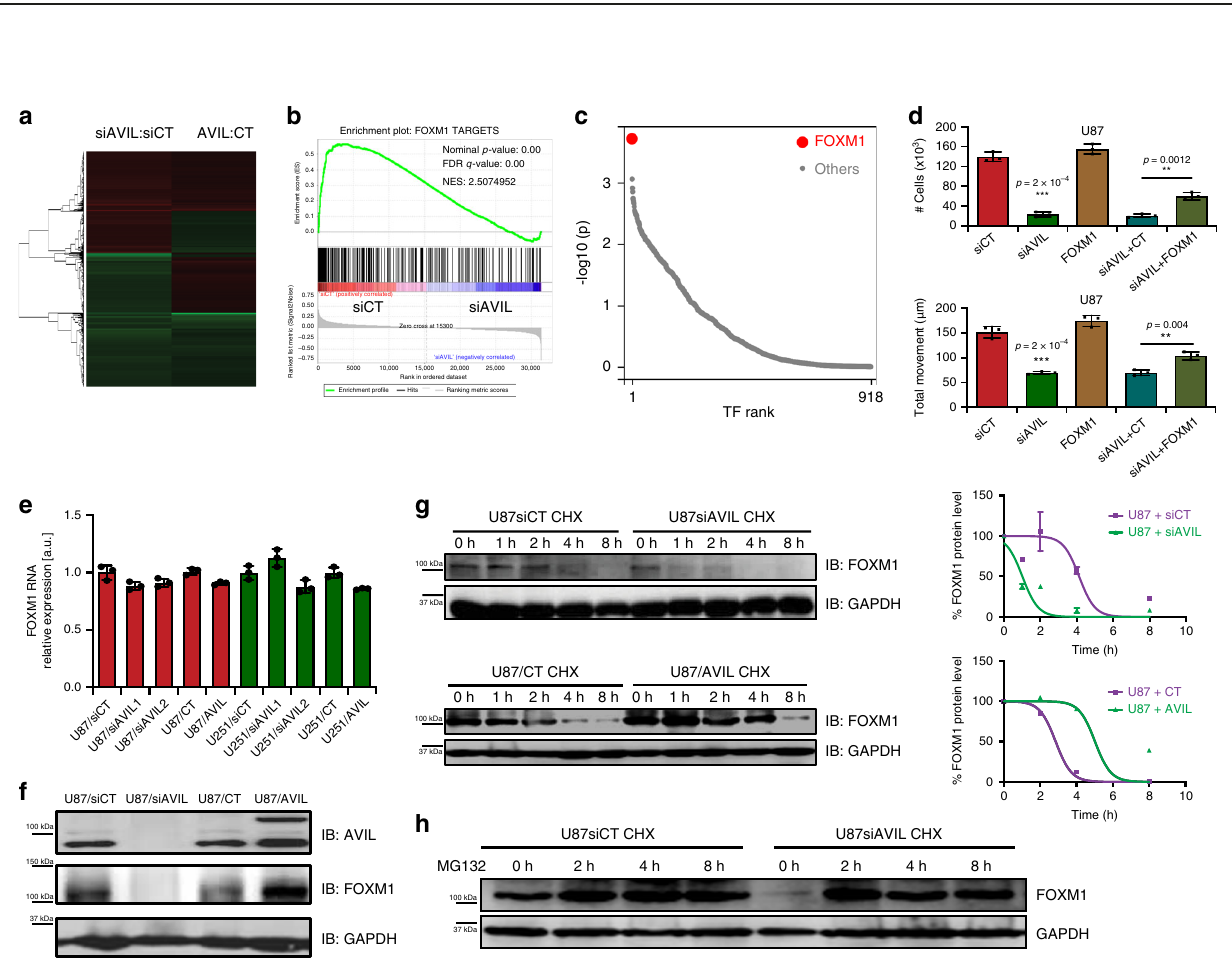
Fig. 6 AVIL binds to F-actin, and the interaction is crucial for its tumorigenic activity. a AVIL colocalize with F-actin. U87 cells stably expressing GFP- AVIL (green) were stained for F-actin (Phalloidin, red) showing co-localization of AVIL and F-actin. b Fluorescence colocalization between F-actin and AVIL. Scatterplot representing the intensity range of red and green pixels in the image as shown in a . c AVIL binds directly to F-actin. Silver-stained SDS- PAGE analysis of actin high-speed pelleting of F-actin in the presence or absence of AVIL. d Silencing AVIL resulted in reduced ability of A172 cells to spread. e Cell area was plotted for A172 cells transfected with siCT, or siAVIL1. Signi fi cant difference ( p = 0.0014) was observed by the two-sided Rank- Sum test (non-parametric test for non-normally distributed data). n > 50. f Amino acid sequence alignment of the C-terminal region of advillin and villin from eight species. Arrows indicate positions selected for mutagenesis; red arrows indicate positions of mutations used in experiments represented in g – j . g Mutations in the headpiece region of AVIL signi fi cantly reduce binding to β -actin in cells. Co-immunoprecipitation of β -actin by antibodies speci fi c to Myc-tag in cell lines expressing Myc-tagged AVIL WT or indicated mutants. Mutants indicated in red were subsequently utilized in experiments represented in h – j . IB – immunoblotting, IP – co-immunoprecipitation. h AVIL mutants are de fi cient in binding to F-actin. Silver-stained SDS-PAGE analysis of actin high-speed pelleting of F-actin in the presence or absence of AVIL in a buffer containing EGTA. i Mutations in AVIL headpiece region are not as effective as WT AVIL in stimulating cell proliferation (two-sided Student ’ s t- test). U87 cells were transfected with siAVIL and grown for 24 h followed by transfection with a plasmid overexpressing AVIL WT or indicated AVIL mutants. After 48 h, cells were counted. j Headpiece mutants failed to rescue de fi ciency in cell movement (two-sided Student ’ s t- test). Total movement of U87 cells expressing AVIL WT or indicated mutants in the wound-healing experiment. Data are presented as mean values ± SD in e , i , and j .